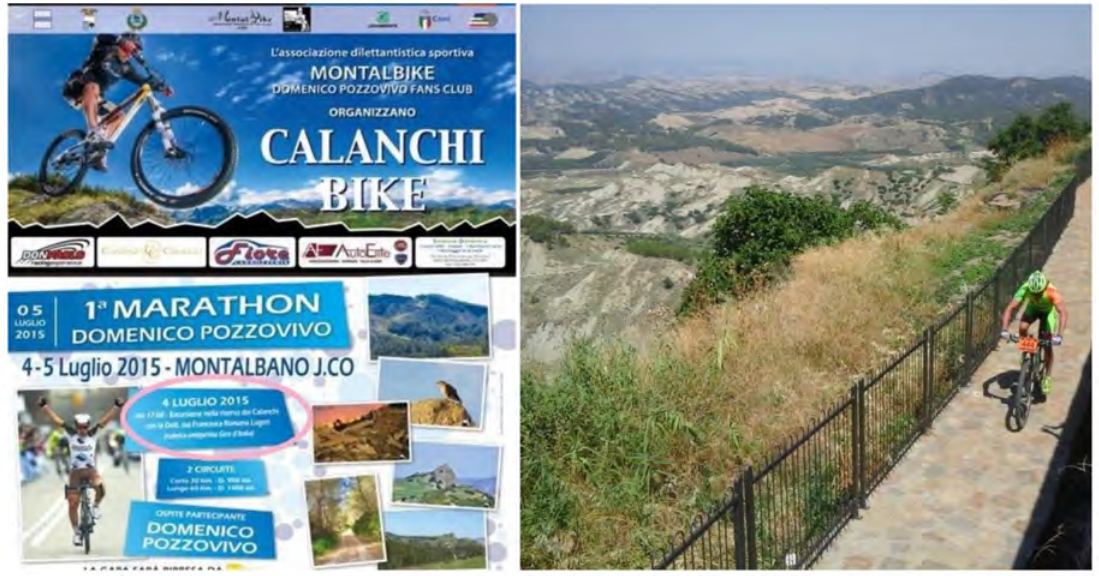
Figure 6. The Calanchi bike marathon. The program included the presence of the geologist (circled in